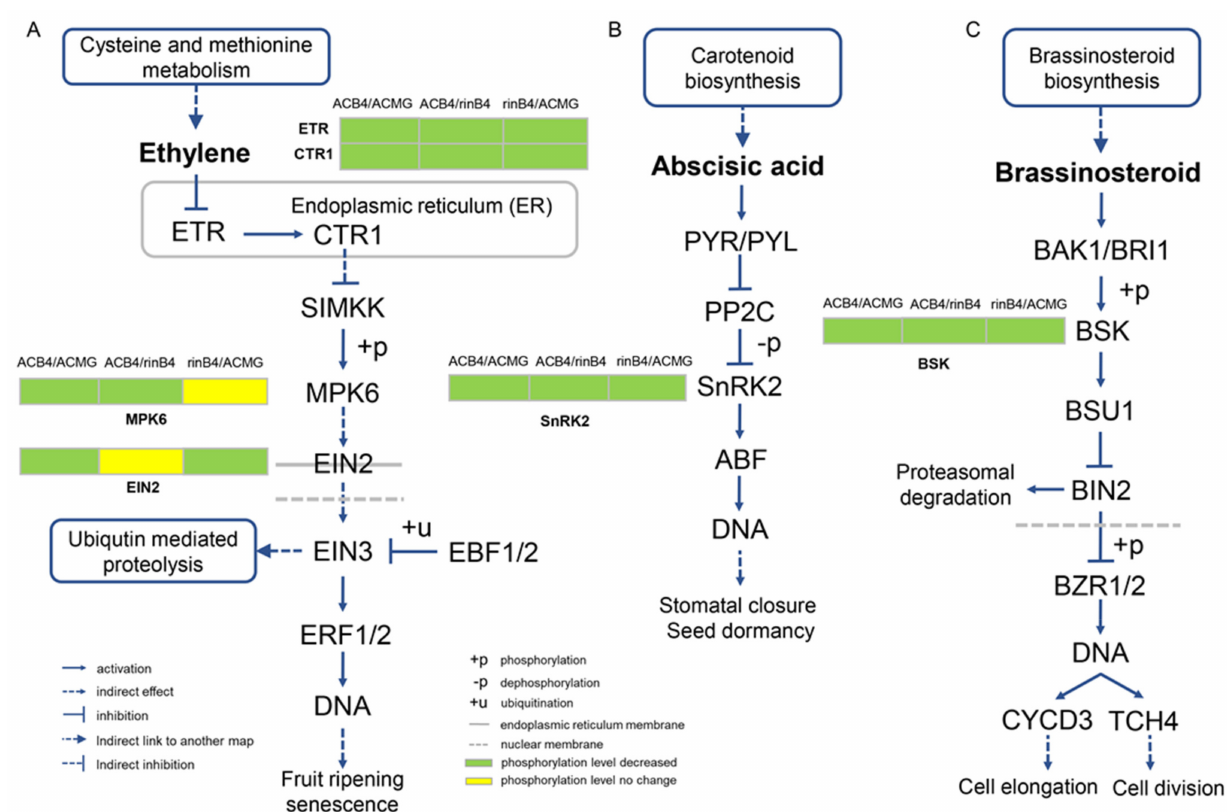
Figure 9. Comparative analysis of ethylene, ABA and the BR signalling-transduction pathway phosphoproteins from different comparison groups. ( A ) Ethylene, ( B ) ABA and ( C ) BR signalling-transduction pathway. MG, mature green; B4, breaker + 4. ETR, ethylene resistant; CTR1, constitutive triple response 1; SIMKK, mitogen-activated protein kinase 4/5; MPK6, mitogen-activated protein kinase 6; EIN2, ethylene insensitive 2; EIN3, ethylene insensitive 3; EBF1/2, EIN3-binding F-box 1/2; ERF1/2, ethylene-responsive factors 1/2; PP2C, protein phosphatase 2C; SnRK2, SNF1-related protein kinase 2; ABF, ABA responsive element binding factor; BAK1, brassinosteroid insensitive 1-associated receptor kinase 1; BRI1, protein brassinosteroid insensitive 1; BSK, BR signalling kinase; BSU1, serine/threonine-protein phosphatase; BIN2, protein brassinosteroid insensitive 2; BZR1/2, brassinosteroid-resistant 1/2; CYCD3, cyclin D3; TCH4, xyloglucan: xyloglucosyl transferase